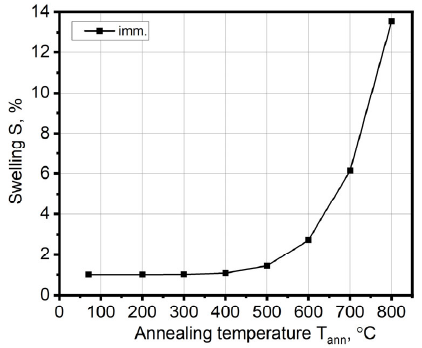
Figure 2. Dependence of swelling S of beryllium irradiated at 70 °C on annealing temperature (for 1 h), reactor SM ‐ 3, F = 2.8 ∙ 10 22 cm − 2 (E > 1 MeV).